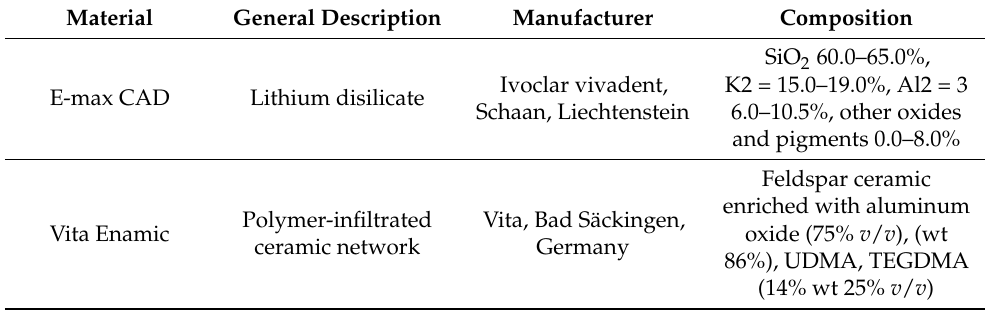
Table 1. General description, manufacturers, and composition of the CAD/CAM blocks employed in the